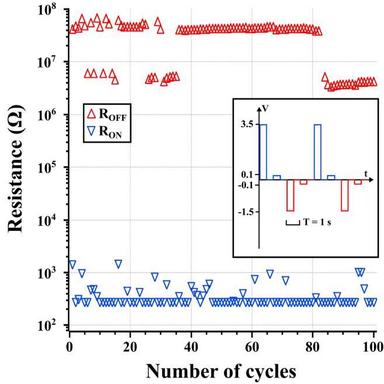
Measured endurance of a Cu/HfO2/Pt memristor. The inset shows the programmed voltage pulses train. After a writing pulse of + 3.5 V a reading pulse of + 0.1 V is applied, then after an erase pulse of − 1.5 V a reading pulse of − 0.1 V is applied. This cycle is repeated 100 times. Each pulse lasts 0.5 s.